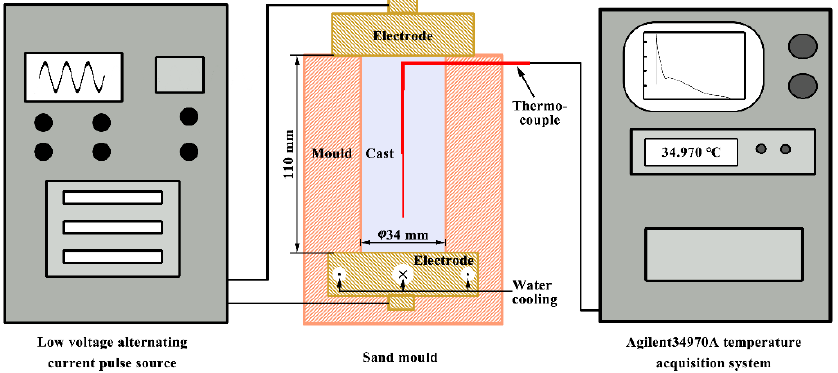
Figure 1. Schematic illustration of the solidification apparatus. Three thermocouples separated by 36 36 mm gaps were positioned along the axis of mm gaps were positioned along the axis of mold.